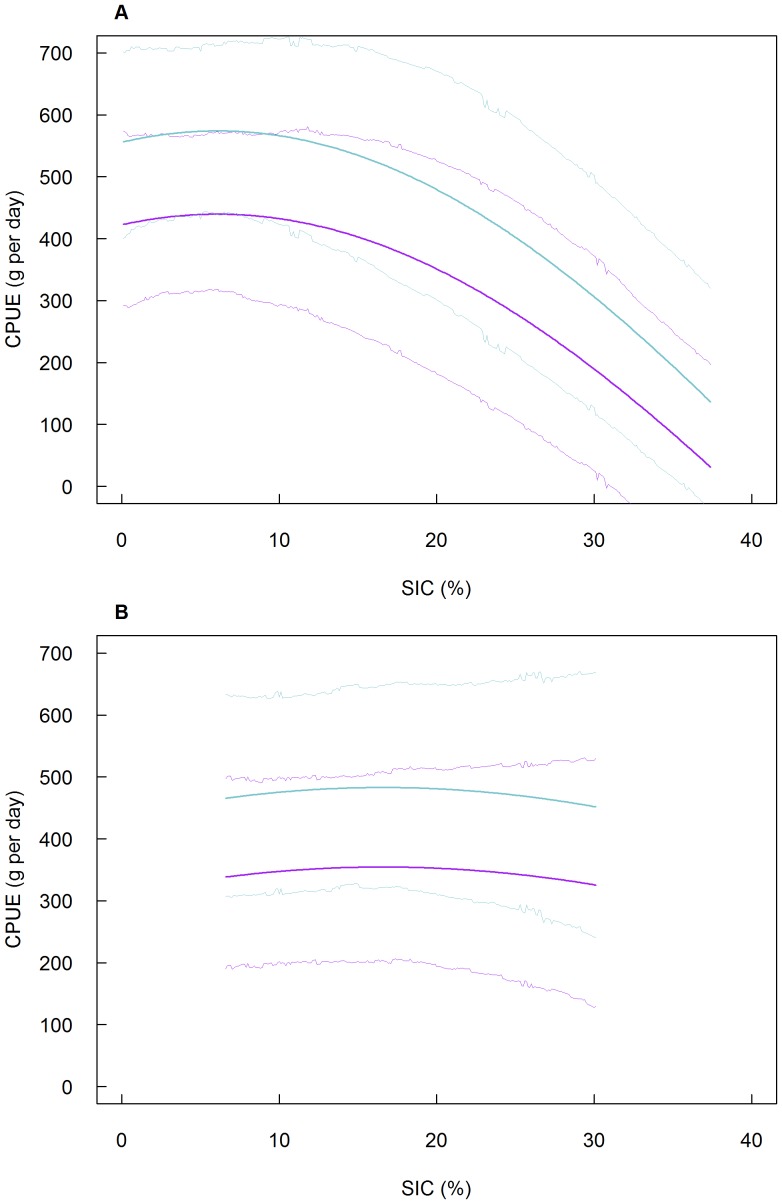
Predicted foraging efficiency (CPUE) of chick-rearing Adélie penguins depending on sea ice concentration.(a) Under “normal” environmental conditions, (b) under extreme (presence of giant icebergs) environmental conditions. Purple and blue lines represent values for females and males, respectively. Thick lines represent the average CPUE for each sex. Thin lines represent 95% Highest Posterior Density intervals computed from the posterior distribution of parameter estimates. Predictions were calculated from the following model: log (CPUE+1) = 0.267+0.069×sex (male)−0.051×Iceberg (yes)−0.010×SIC+(−0.074+0.075×Iceberg (yes))×SIC2.